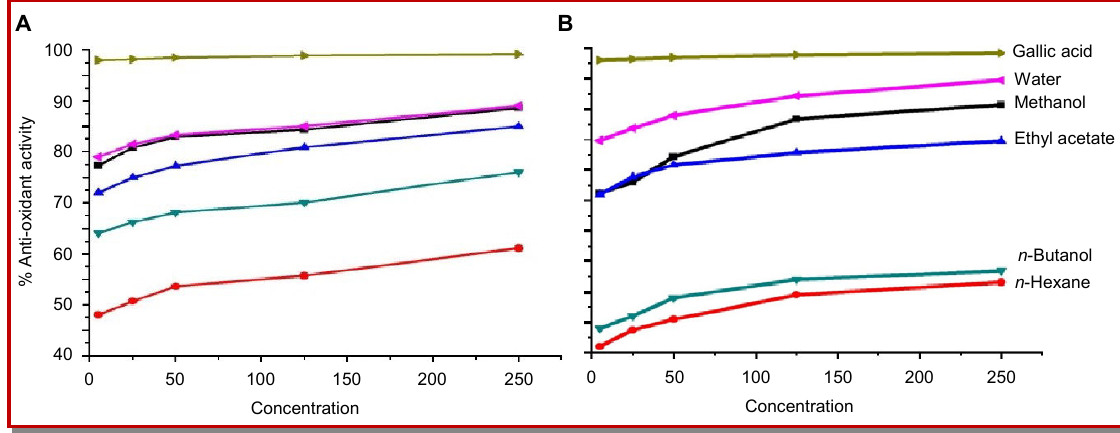
Figure 2: Antifungal potential of different solvent extracted samples of leaf against R. oryzae (A) and A. flavus (B)